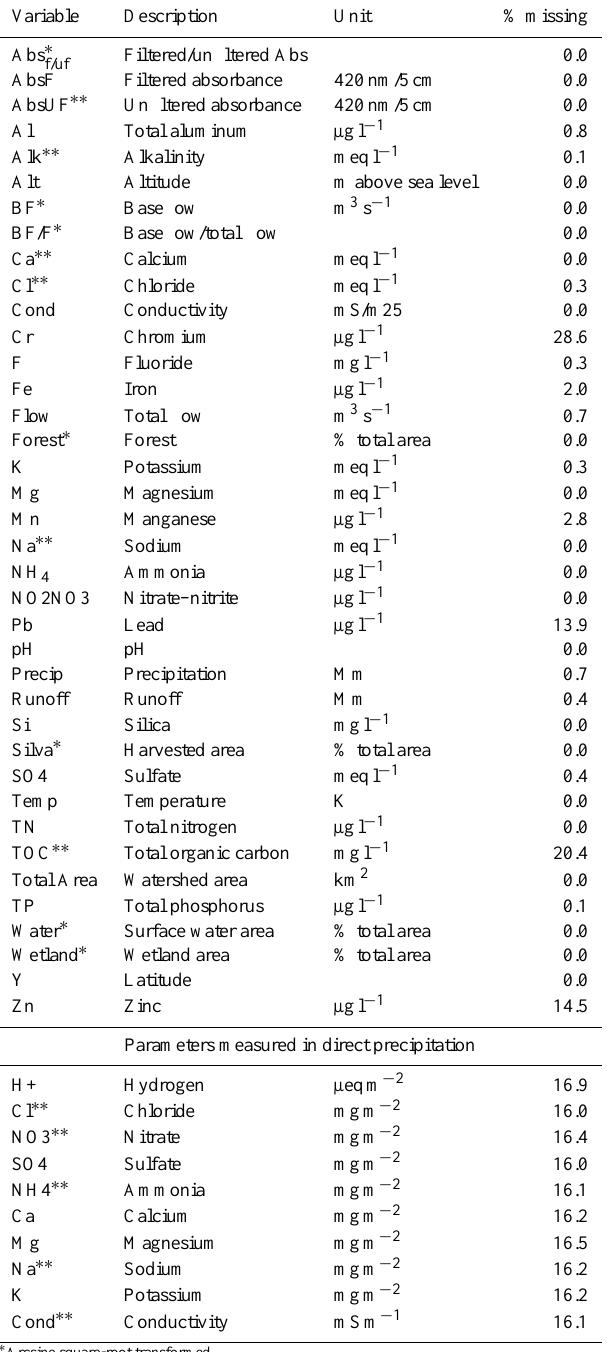
∗ Arcsine square-root transformed. ∗∗ Removed due to multicollinearilty (correlation factor >